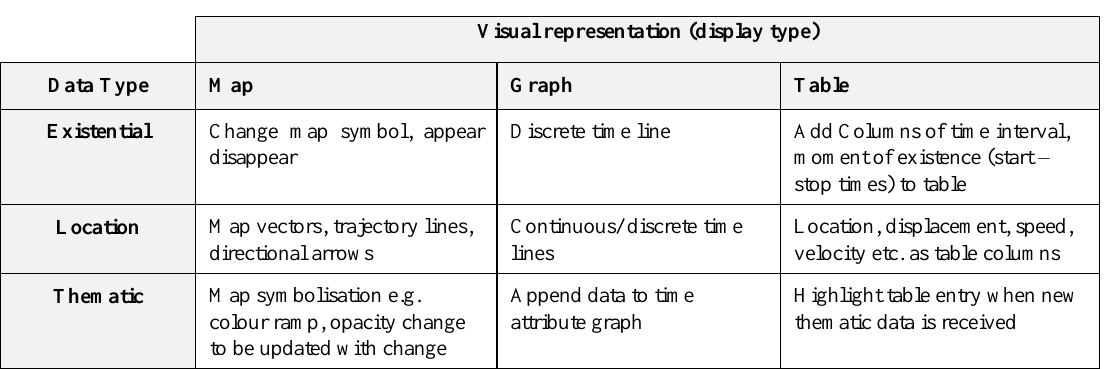
Table 1. Example of relationship between data type and visual representations that user would expect, with respect to continuously updating data